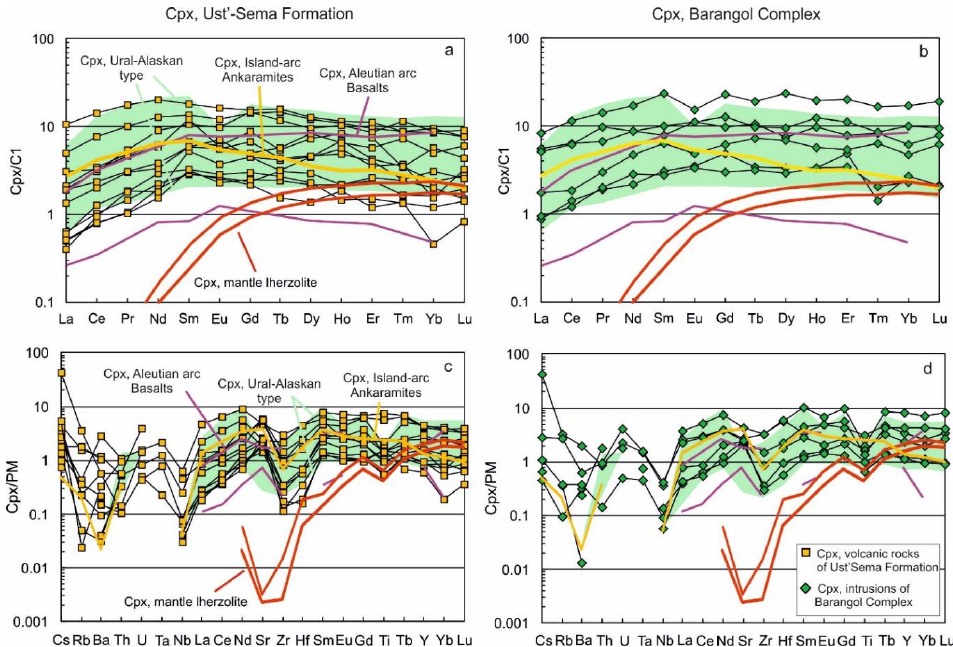
Figure 13. ( a , b ) Chondrite-normalized spectrum distribution of the rare-earth elements [26] and ( c , d ) primitive mantle-normalized spider diagrams [32] for the clinopyroxenes from the Ust’-Sema Formation and the Barangol Complex rocks compared with clinopyroxene compositions from island arc ankaramites [33] and mantle lherzolite of the Kamchatsky Mys [31] are shown. Continued line: core of crystal; dashed line: rim of crystal with clinopyroxene from island arc ankaramites [33], Ural–Alaskan-type intrusions [42], and basalts of the Aleutian arc